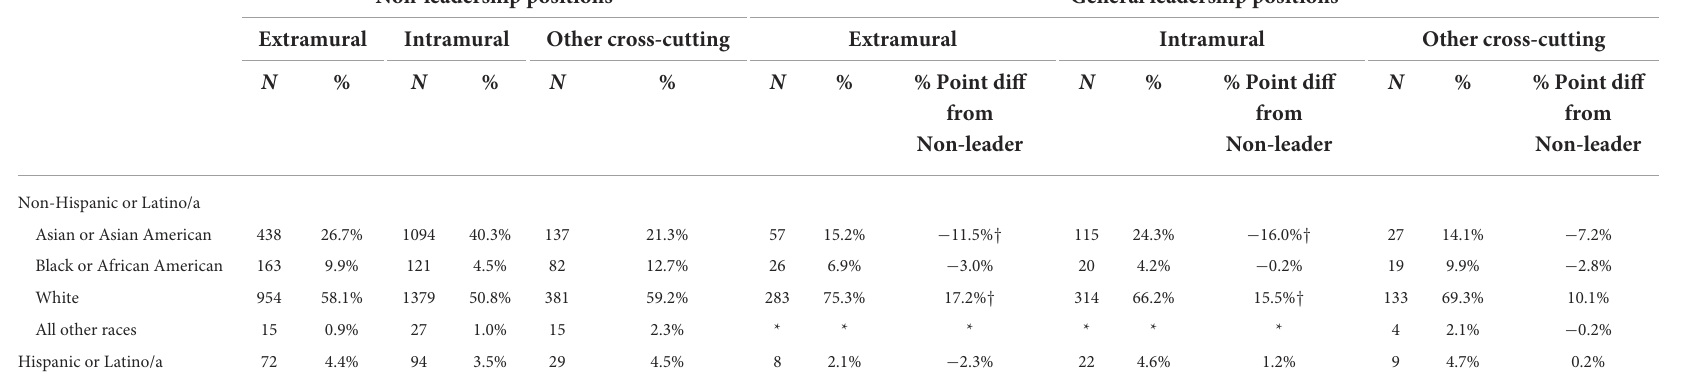
TABLE 3 Leadership disparities in scientific occupation series 0401 and 0601 by race and ethnicity by organization unit type in fiscal year 2021. Non-leadership